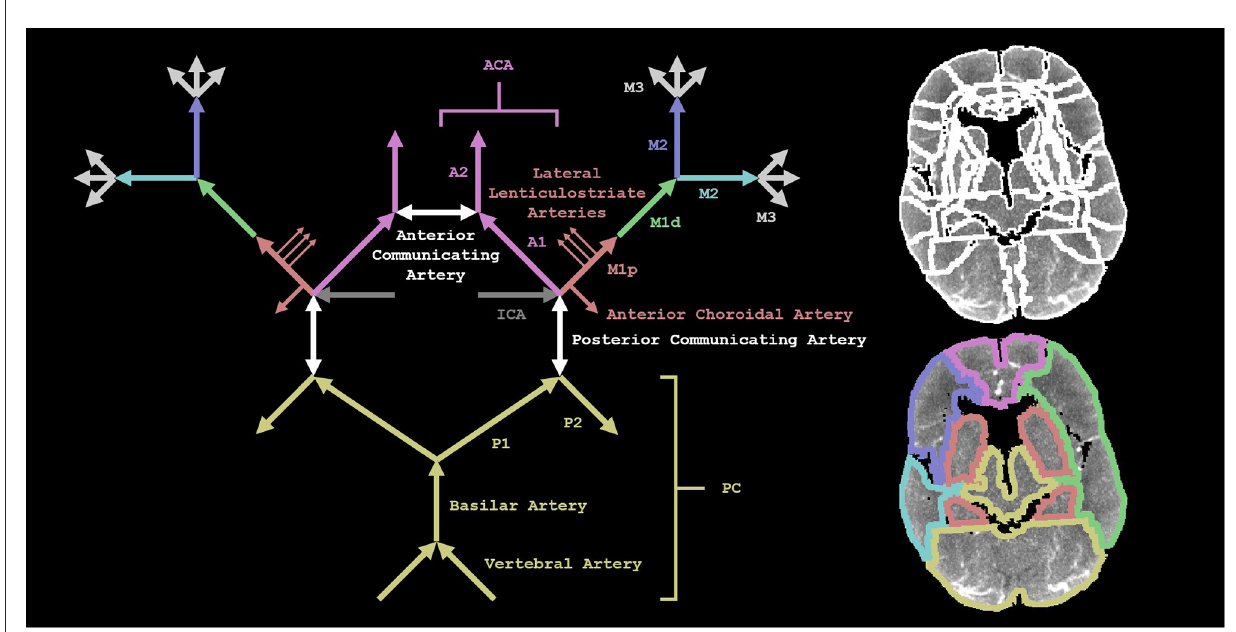
FIGURE1 A visual representation of our methods. On the left is a schematic depiction of the arterial blood supply of the brain. The annotations from CTA did not specify between different M2 (or M3) branches. On the top right, we show the regions from a neuroanatomical CT-MRI brain atlas specific to the stroke population (registered to the CT perfusion scan of a patient) (12). On the bottom right, the neuroanatomical regions (shown on the top right) are grouped to constitute downstream regions that correspond to the vessel occlusion locations (shown on the left). We show the M1d downstream region in the left hemisphere and the two M2 downstream regions in the right hemisphere.